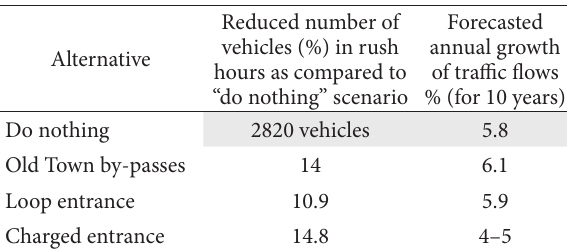
Table 5. Summary of modelling and expert evaluation results